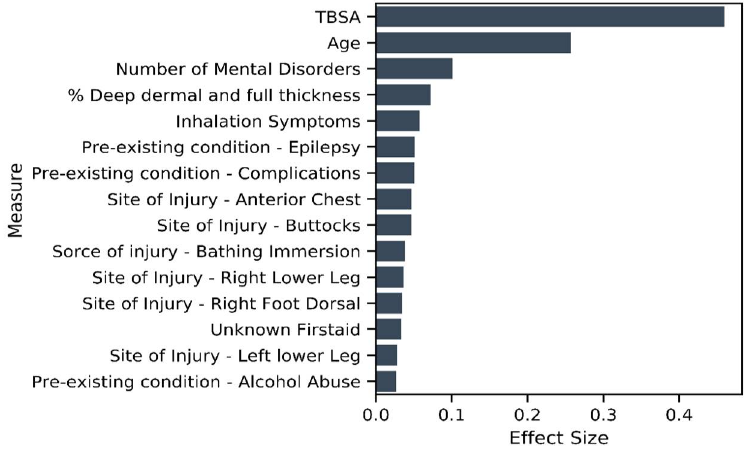
Figure 7. Variables of importance—top 15 contributors from 212 significant variables in the uni- tary model.